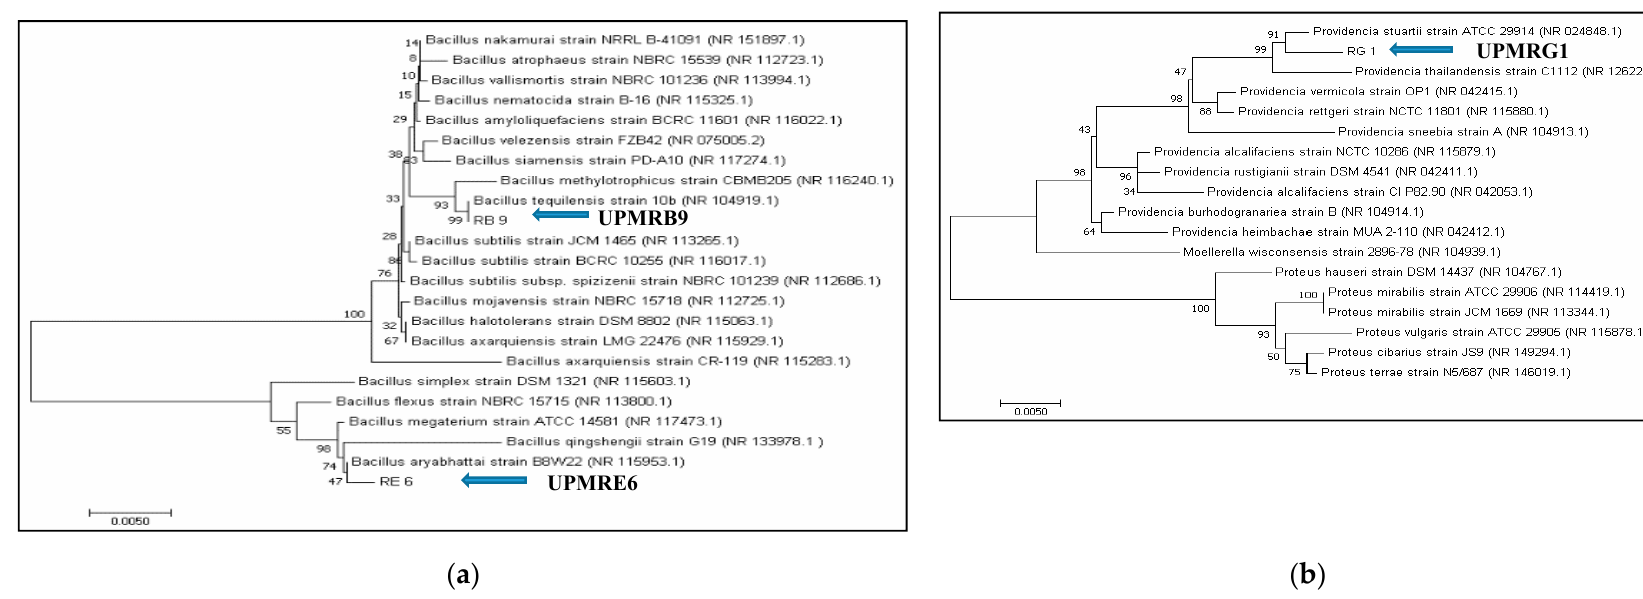
Figure 1. ( a ): Neighbor-joining tree based on the 16S rRNA gene sequence showing the phylogenetic relationship of UPMRB9 and UPMRE6 to related isolates; bar represents the nucleotide divergence value. ( b ): Neighbor-joining tree based on the 16S rRNA gene sequence showing the phylogenetic relationship of UPMRG1 to related isolates; bar represents the nucleotide divergence value.